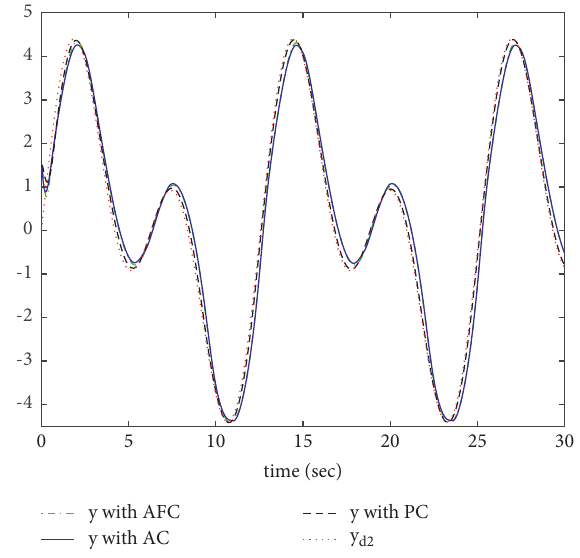
Figure 7: The trajectories with x